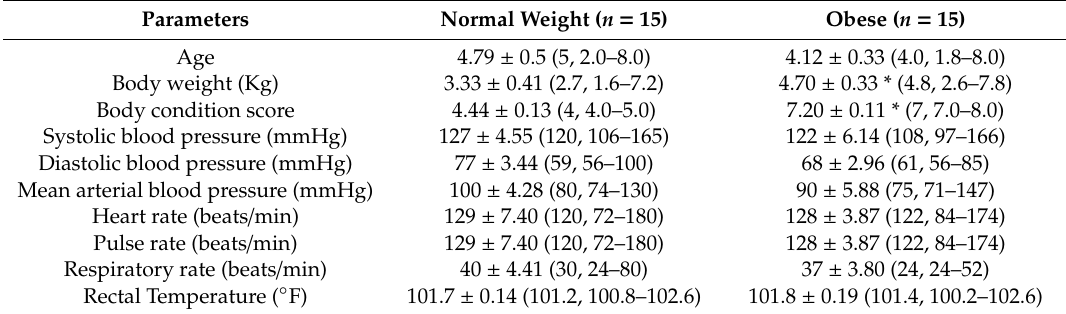
Table 1. Baseline characteristics of normal weight and obese groups. Mean ± SE (median, minimum–maximum) are